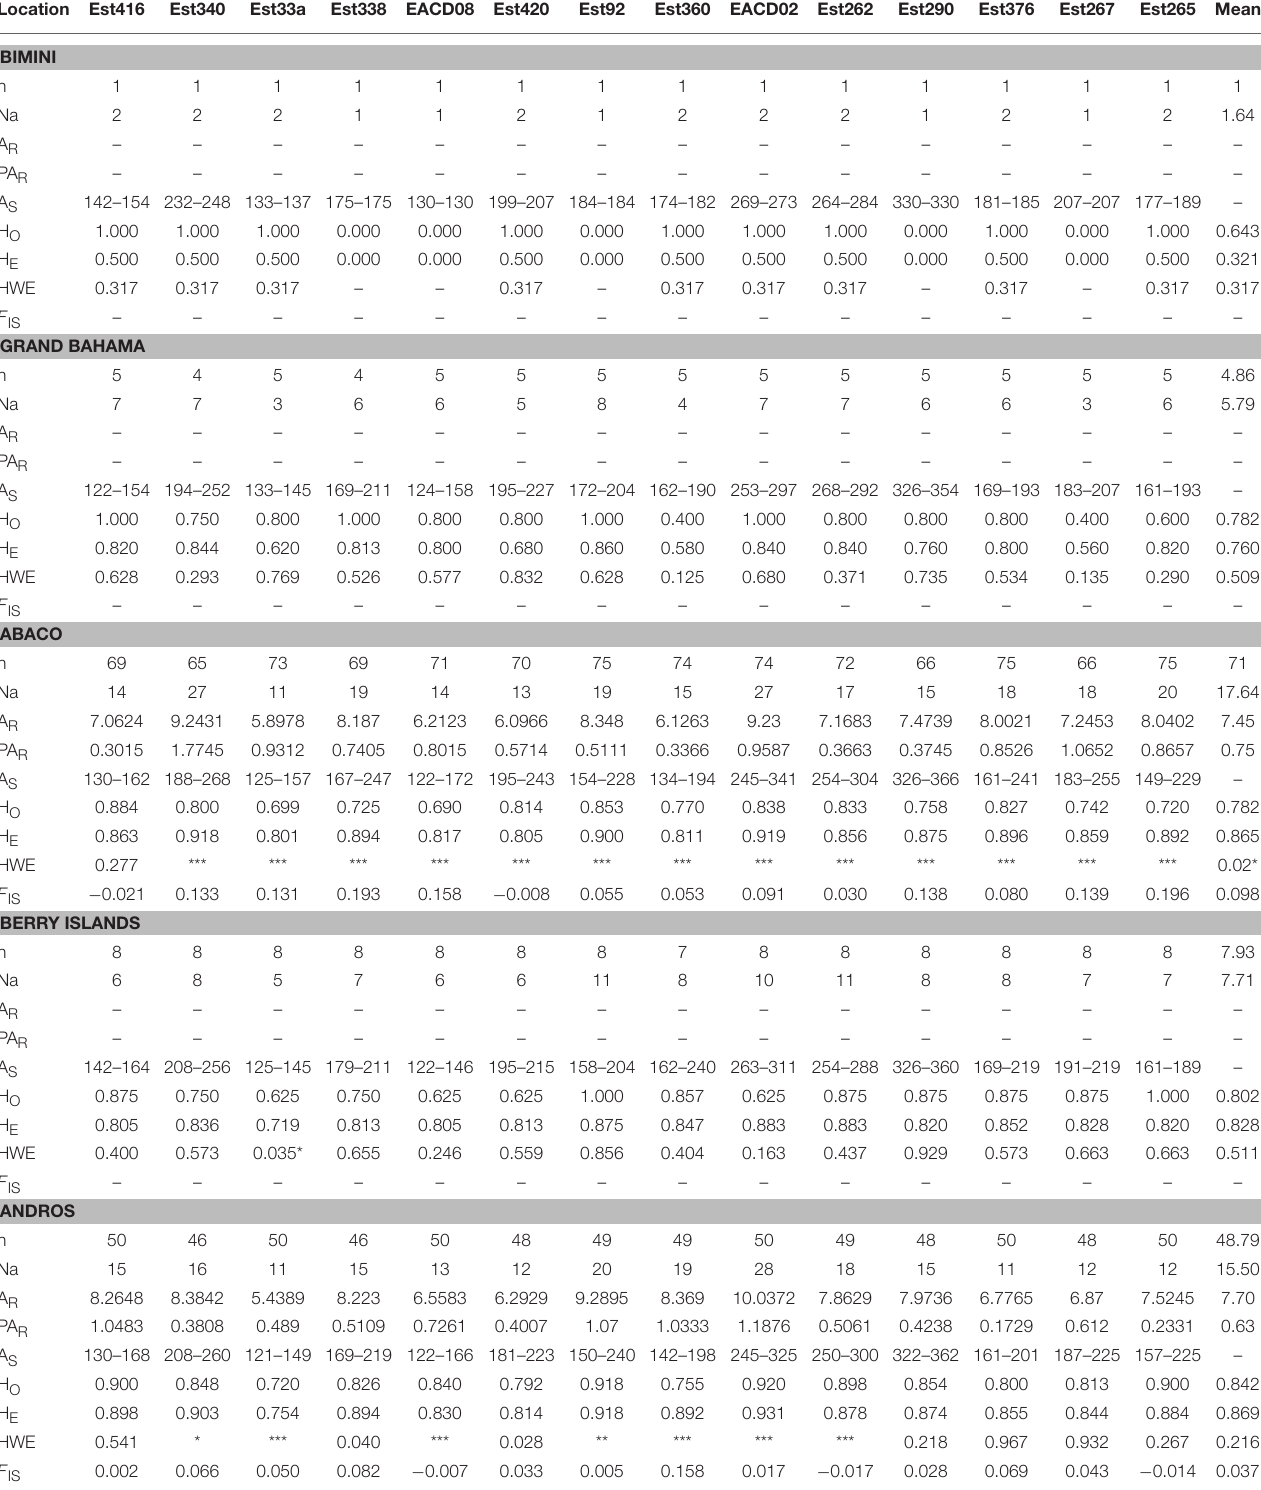
TABLE 2 | Genetic Diversity Summary Statistics for Nassau Grouper where n, number of individuals; Na, number of effective alleles; A R , allelic richness; PA R , private allelic richness; A S , size range of alleles; H O , observed heterozygosity; H E , expected heterozygosity; HWE, probability of conforming to Hardy-Weinberg equilibrium, F IS , inbreeding coefficient. Location Est416 Est340 Est33a Est338 EACD08